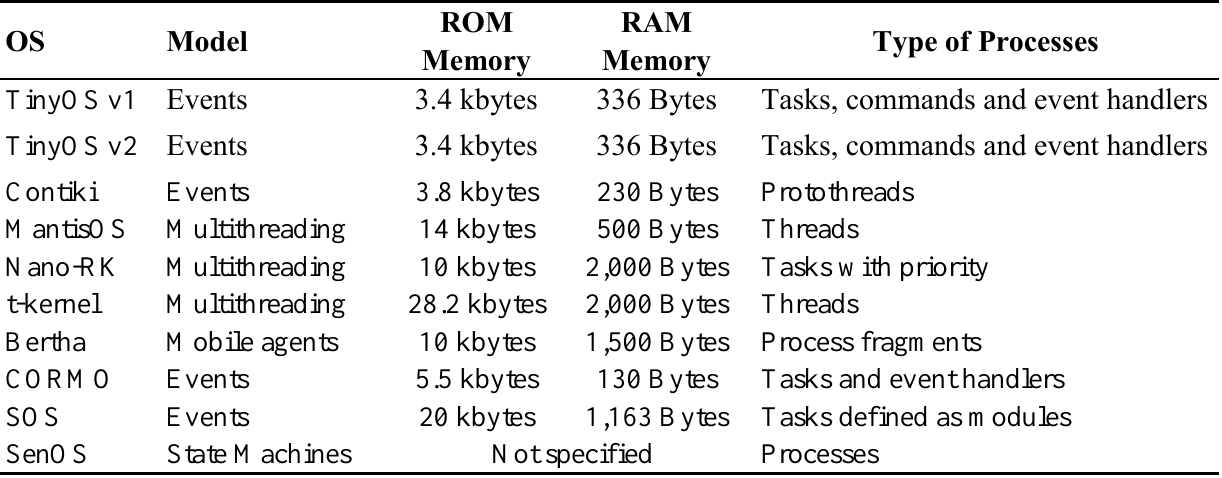
Table 1. Operating Systems for Wireless Sensor